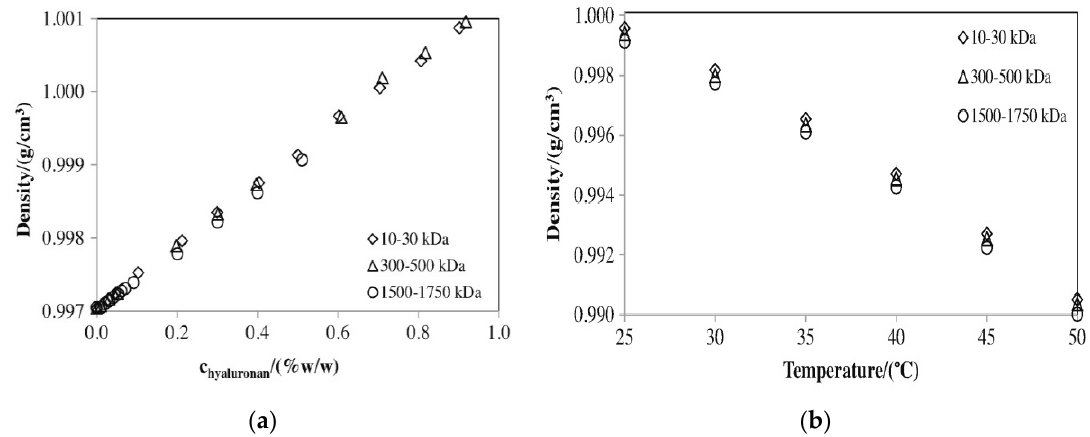
Figure 14. Dependence of density on ( a ) hyaluronic acid concentration and ( b ) temperature. Molecular weights of hyaluronan are as follows: ◊ 10–30 kDa; ∆ 300–500kDa; ○ 1500–1750 kDa. Reproduced from [80], with permission from Elsevier, 2020.